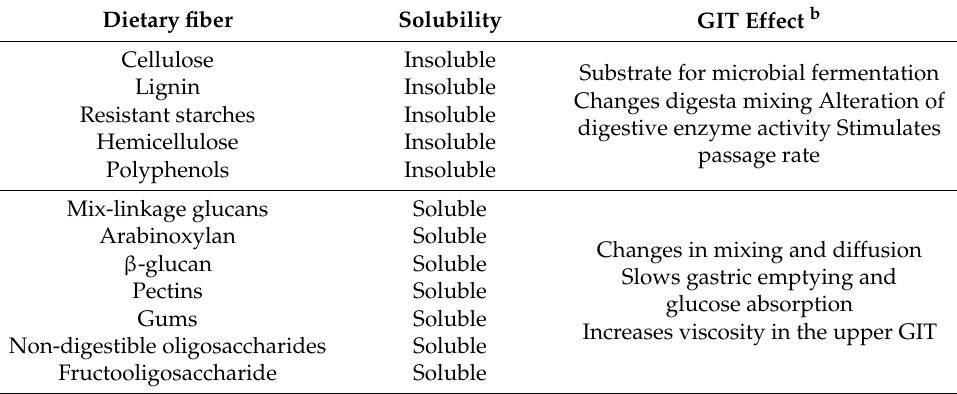
Table 3. Characteristics of dietary fiber and relationships to gut effects a . Dietary fiber Solubility GIT Effect b Cellulose Insoluble Substrate for microbial fermentation Changes digesta mixing Alteration of digestive enzyme activity Stimulates passage Soluble Changes in mixing and